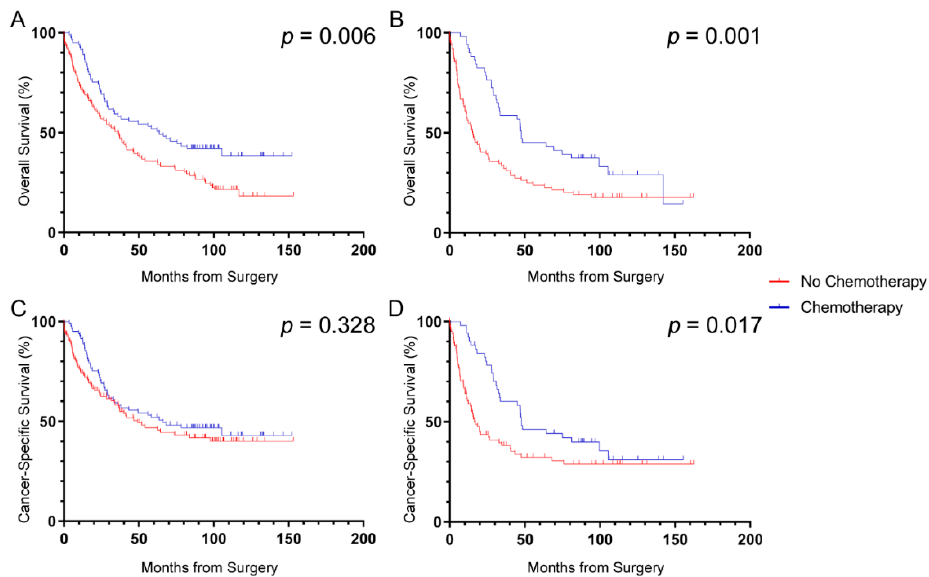
Figure 3. Effect of SOX2 density on survival benefit from chemotherapy in patients with stage III CRC. Patients with stage III disease that had ( A ) low or ( B ) high SOX2 density both demonstrated significant benefit in overall survival from adjuvant chemotherapy. Patients that had ( C ) low SOX2 density did not demonstrate a benefit in cancer-specific survival whereas those with ( D ) high SOX2 density did benefit from chemotherapy. Log-rank p -values shown.